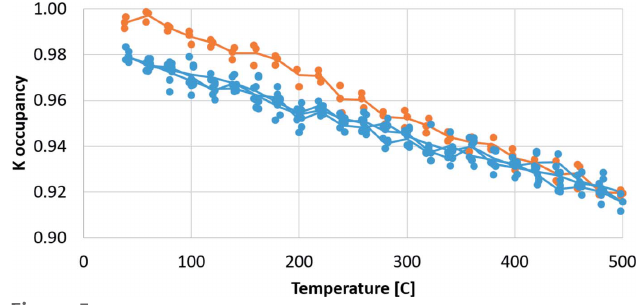
Figure 5 Refined K-occupancies as a function of temperature. Orange points were collected on the first heating ramp.